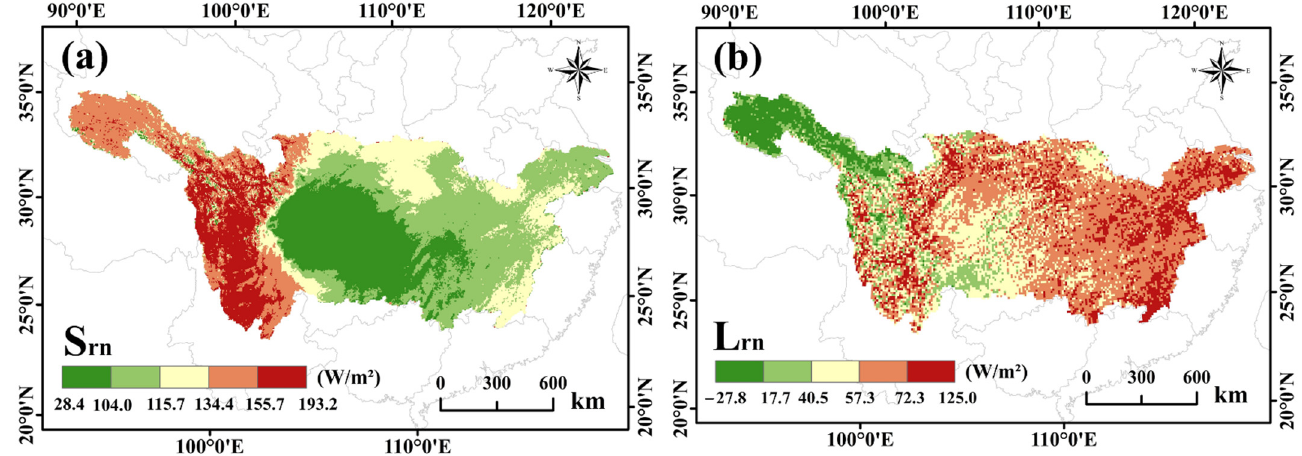
Figure 4. Spatial differences of ( a ) net short-wave radiation ( S (cid:2928)(cid:2924) ) and ( b ) net long-wave radiation ( L (cid:2928)(cid:2924) ) in the Yangtze River basin from 2000 to 2020. As shown in Figure 5, the highest value of S (cid:2928)(cid:2924) was in the PP region, where its multi- year average maximum value was 130.2 W/m (cid:2870) , while the lowest value was located in the OU area, where the multi-year average minimum value was 110.3 W/m (cid:2870) . The results of L (cid:2928)(cid:2924) showed the maximum value of the multi-year average was located in the OU region, where its value was 68.1 W/m (cid:2870) , followed by the MP, CP, UE, and PP regions, and their values were 63.1 W/m (cid:2870) , 59.4 W/m (cid:2870) , 58.8 W/m (cid:2870) , and 52.3 W/m (cid:2870) , respectively.